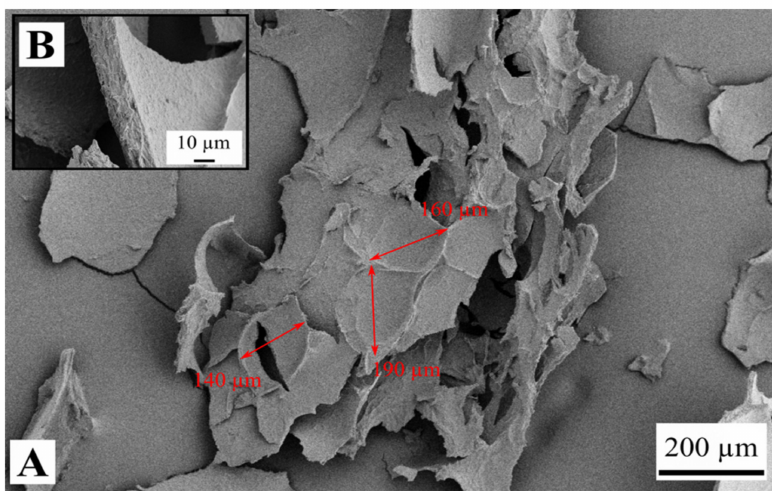
Figure 6. Structure of the sample FD-NG-FR derived from 5 wt.% starch suspension and freeze-dried at sublimation pressure of 2.38 mbar. Picture ( A ) shows an overview of the material structure and picture ( B ) a dense pore wall with higher